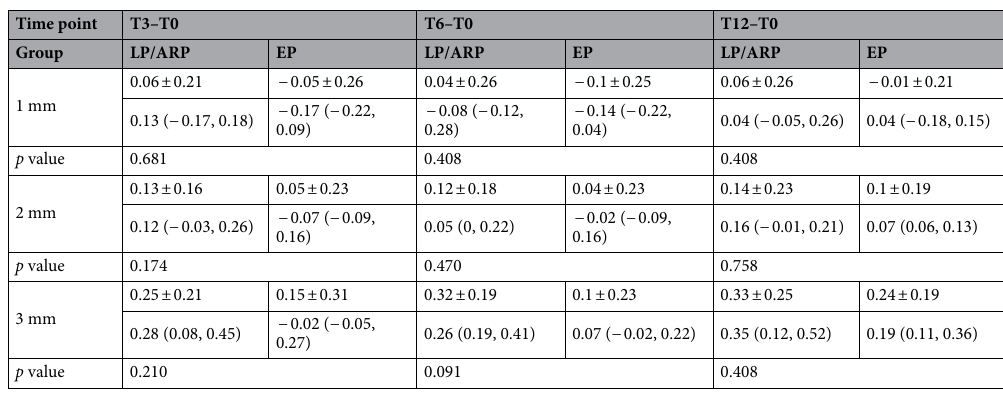
Table 2. Linear tissue changes at the mid-facial area on the soft tissue level. Data are presented as a mean ± standard deviation, median (1st quartile, 3rd quartile). Positive and negative numbers indicate gain and loss, respectively. LP/ARP: late implant placement following 4 months of alveolar ridge preservation, EP: early implant placement. There were no statistically significant differences between the two groups at all